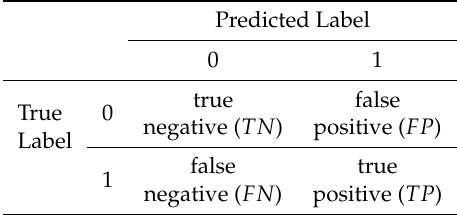
Table 3. Confusion matrix of the proposed bagged tree